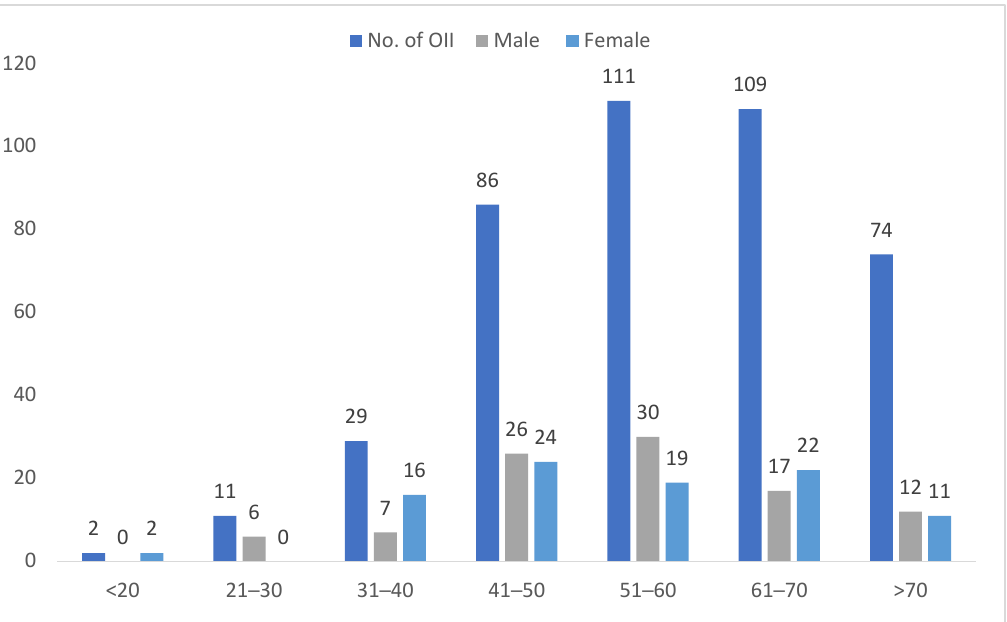
Figure 1. Implant distribution by gender and age range . Table 2. Demographic data and medical histories of the sample. N: number; OII: number of im- plants. HIV: human immunodeficiency virus; NSAIDs: nonsteroidal anti-inflammatories.